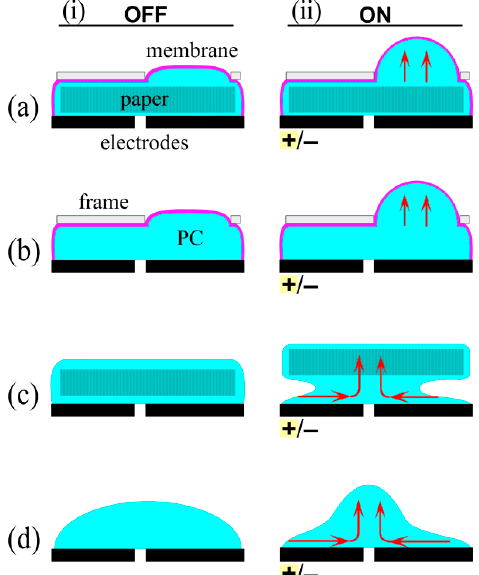
Figure 4. Schematic representation of fluid motion in the adjacent layout. ( ai ) The actuator